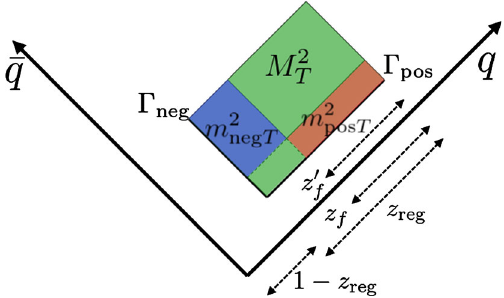
Fig. 29 The two possibilities for the final breakup, in blue, and the final region, in red, in a q ¯ q system. The two old breakups, v neg and v pos , are also represented in red